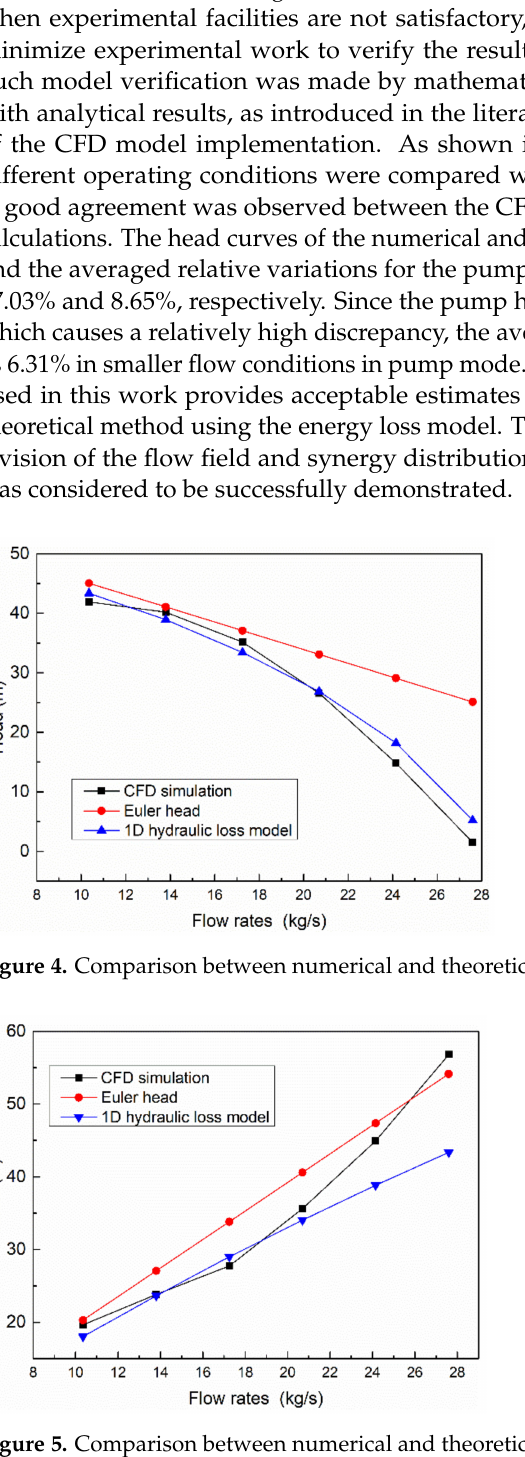
Figure 5. Comparison between numerical and theoretical results of the